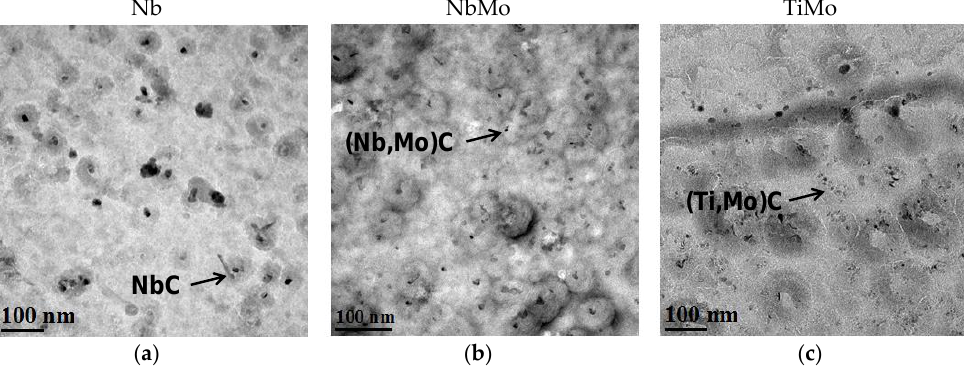
Figure 6. Presence of fine precipitates in the microstructures after coiling temperature of 700 °C for different steels: ( a ) Nb (NbC); ( b ) NbMo ((Nb, Mo)C); and ( c ) TiMo ((Ti, Mo)C). Metals 2017 , 7 , 65